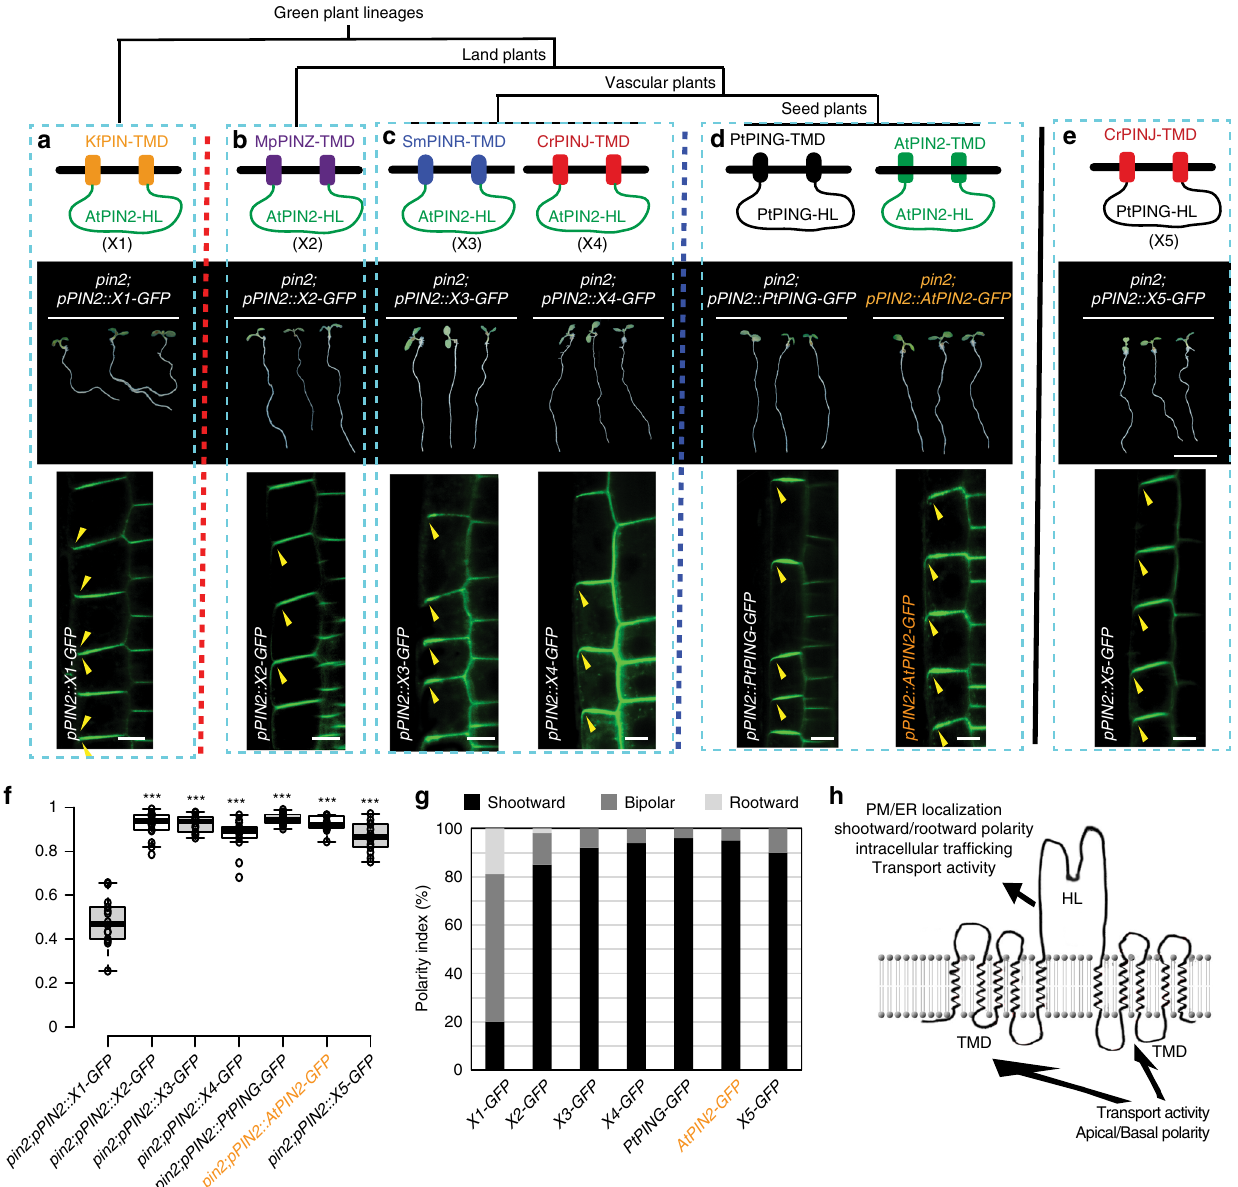
Fig. 4 Functional innovations of PIN2 during plant evolution. a – e Hybrid PIN (X1) with the central hydrophilic loop (HL) of green alga KfPIN substituted by the Arabidopsis AtPIN2 HL fused with GFP (HL-GFP) failed to rescue the pin2 mutant ( a , middle panel). Hybrid PIN proteins (X2-X4) with the central HL of marchantiophyte MpPINZ, lycophyte SmPINR, and fern CrPINJ replaced by the Arabidopsis AtPIN2 HL-GFP were able to rescue the defective root gravitropism phenotype of the Arabidopsis pin2 mutant ( b , c , middle panels). The PtPING and AtPIN2 proteins with GFP fused with the central HL can complement the pin2 mutant phenotype ( d , middle panel). Scale bars, 1 cm. The hybrid PIN protein (X5) with the central HL of CrPINJ replaced with the gymnosperm PtPING HL fused with GFP successfully complemented the Arabidopsis pin2 mutant phenotype ( e , middle panel). The cellular localization of hybrid PIN proteins (X1 – X5) and the PIN2-GFP and PtPING-GFP fusion proteins in Arabidopsis root epidermal cells with expression driven by the AtPIN2 promoter ( a – e , lower panels). All and only PIN2 chimeric proteins that were able to localize to the shootward cell side also rescued the pin2 gravitropism. Scale bars, 10 µ m. The red and blue dashed lines indicate the separate two functional innovations at different plant evolution stages. f Quanti fi cation of vertical growth index (VGI) for the transgenic lines in a – e ( n ≥ 10 roots). Center lines show the medians; box limits indicate the 25th and 75th percentiles as determined by R software; whiskers extend 1.5 times the interquartile range from the 25th and 75th percentiles, outliers are represented by dots. Student ’ s t -test, *** P < 0.001, compared with the pin2 ; pPIN2::X1-GFP , respectively. g Polarity index of the cellular localization of the PINs in epidermal cells in ( a – e , lower panels) ( n = 150 to 200 cells from ten roots). h Schematic showing the contributions of the TMDs and the HL domain to PIN2